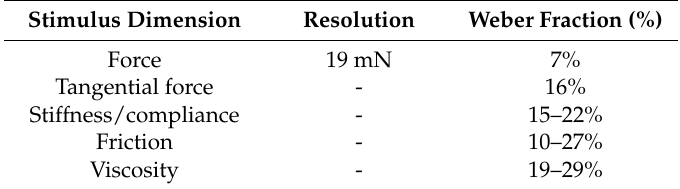
Table 1. Sensory resolution and weber fractions for a range of haptic stimuli